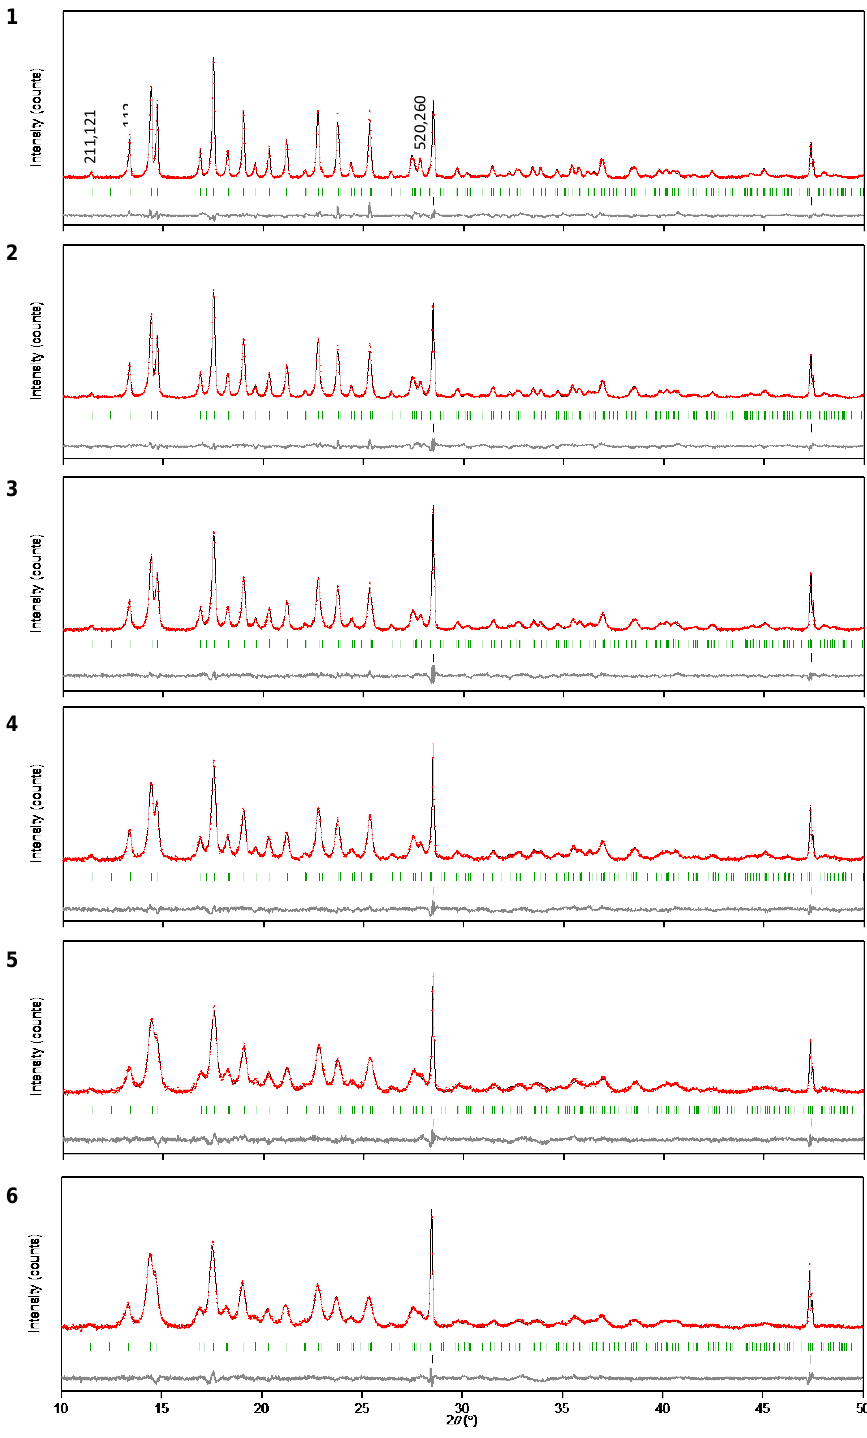
Figure 1. XRD patterns with Rietveld analyses of 1 – 6 . Red plots, black lines, blue lines, green bars, and black bars are the observed patterns, calculated patterns, residue between the calculated and observed patterns, calculated positions of the Bragg reflections in the sample, and those of the silicon (Si) standard, respectively. The XRD peaks due to Si are shown as black sticks. Representative reflection indexes are shown in the XRD pattern of 1 .